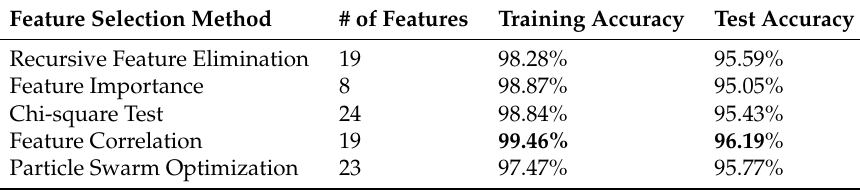
Figure 1. Correlation heatmap of features for the first stage ML model. Table 4. Performance of feature selection techniques for the first stage ML